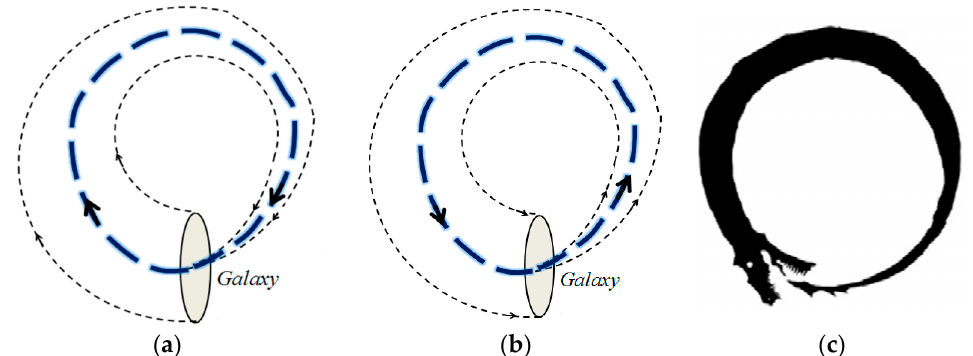
Figure 4. Loopback of the light cone: ( a ) the path of the rays which form the image of the Galaxy (cosmic mirror effect) in the telescope lens with a closed central null-geodesic; a thin dotted line shows the light cone between the Galaxy and the observer, the thick dotted line is the central null-geodesic; ( b ) an illustration of the fact that only the central ray is closed; ( c ) the Ouroboros (figure copied from the site “Ya-webdesign.com”—images for free download).